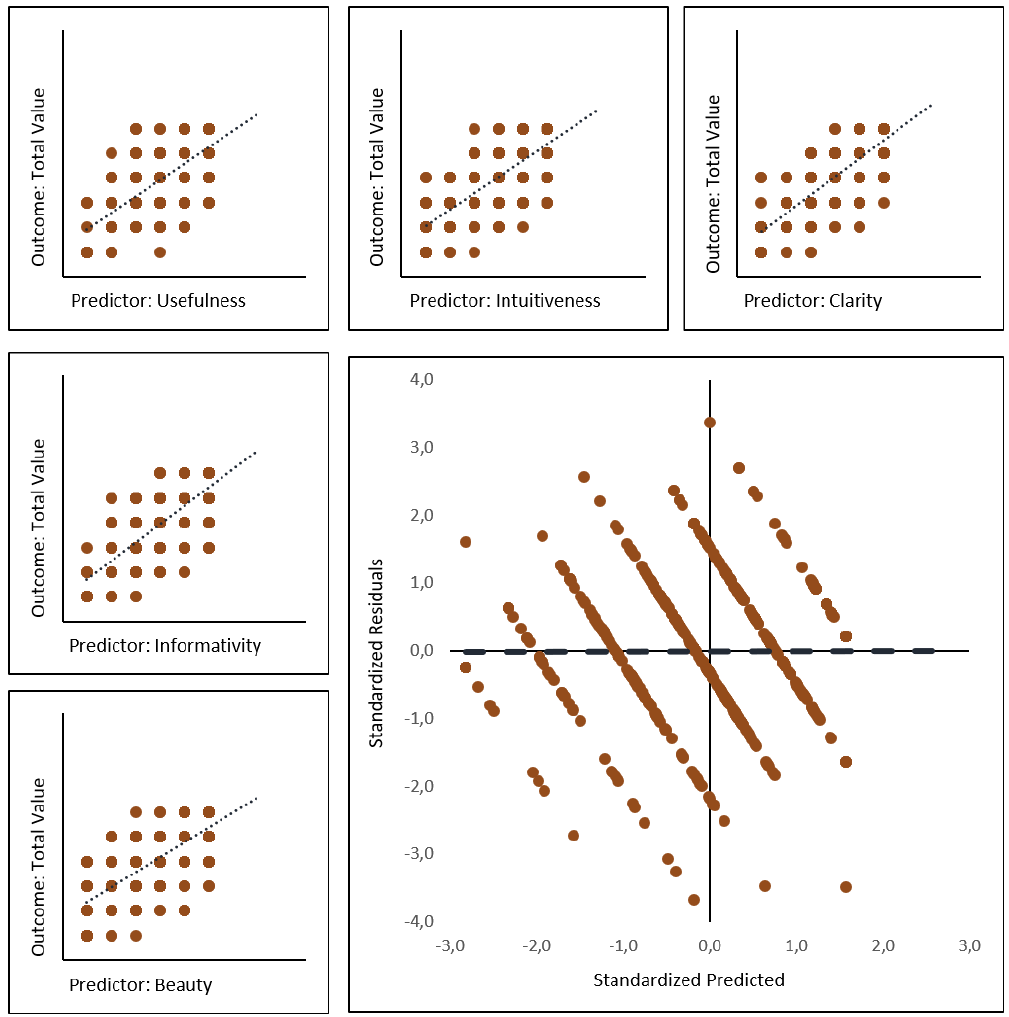
Figure 7. Linearity and homoscedasticity of raw